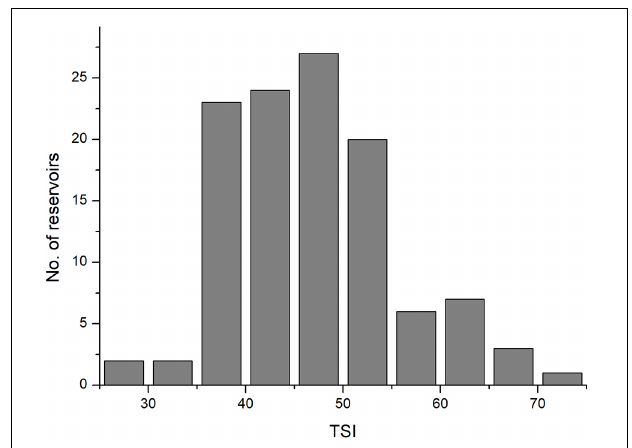
FIGURE 1 | Histograms plot showing the summary statistics of TSI in 115 sampled reservoirs of southern China.